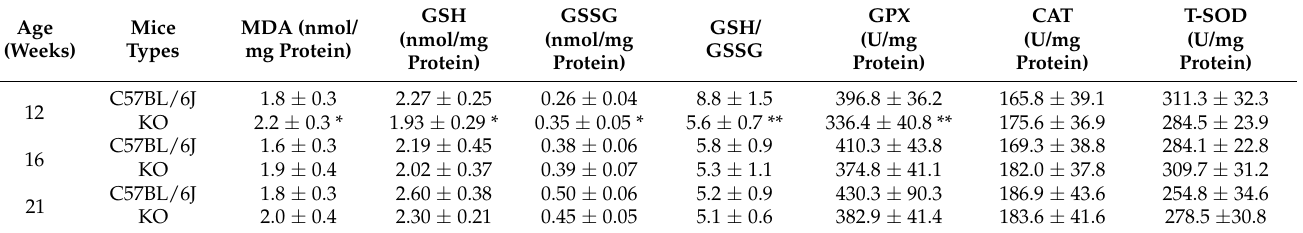
Table 2. Effects of SELENOF knockout on hepatic oxidative stress parameters in mice of different